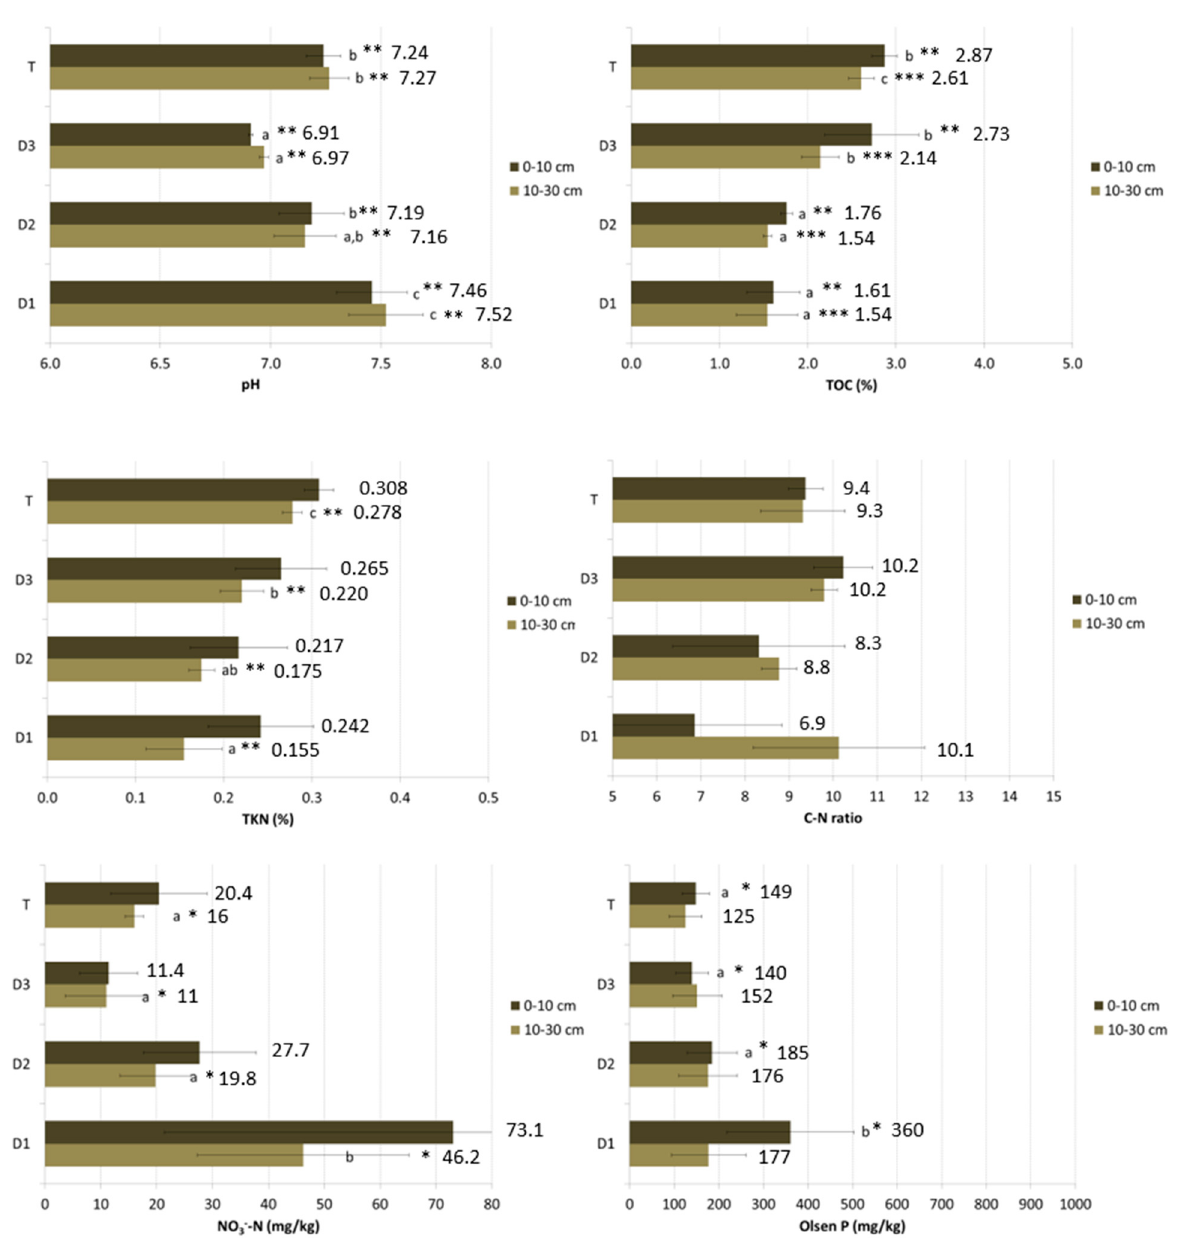
Figure 3. Average values and standard deviation for each sampling position and depth (FC). Different letters correspond to statistically significant differences among the means of measurements of the same depth at different distances. * significant at p ≤ 0.05, ** significant at p ≤ 0.01, *** significant at p ≤ 0.001, according to ANOVA.